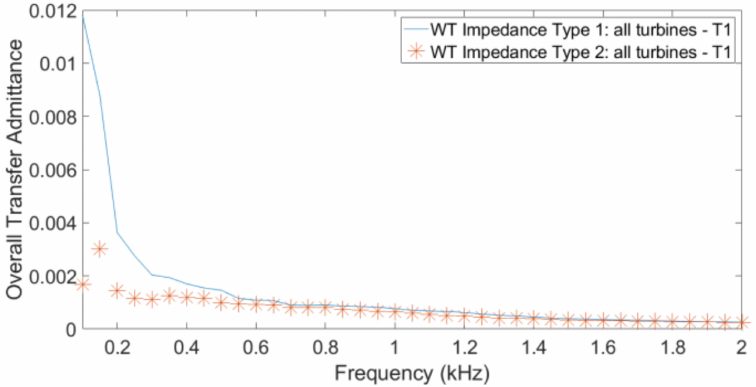
Figure 14. Impact of WT impedance on overall transfer admittance from all turbines to one turbine: 42-turbine wind power